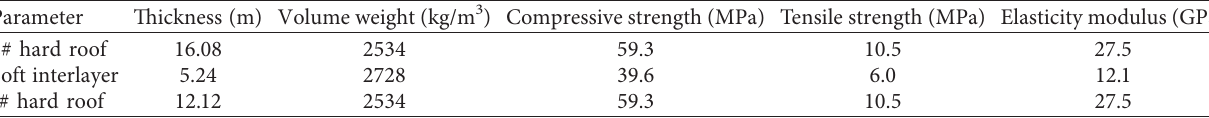
Table 3: Mechanics parameters of 1# and 2# hard roof and soft